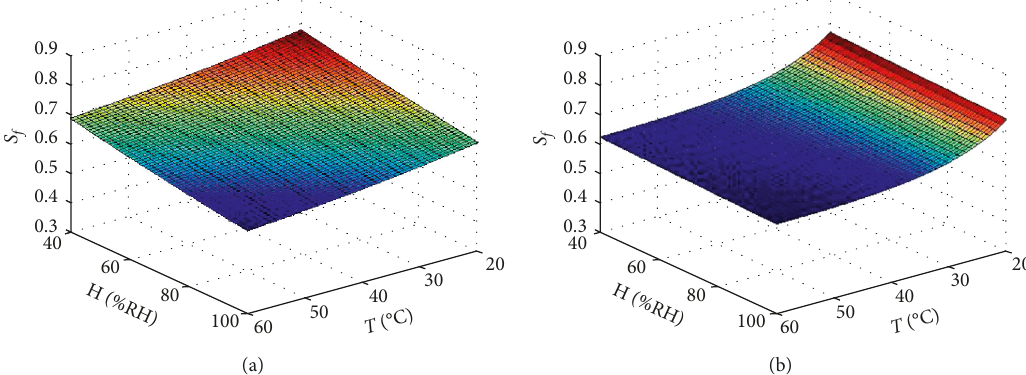
Figure 7: The influence of hot-wet environments on the relative fatigue limit S